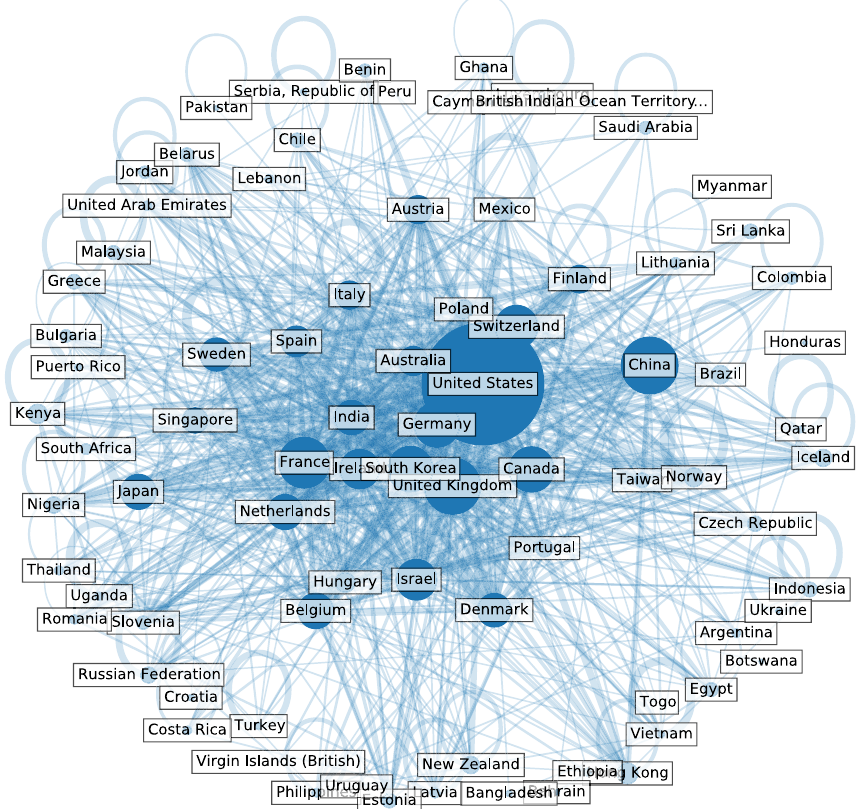
Fig. 1 Projection of the bipartite network on the firms’ layer, aggregated by